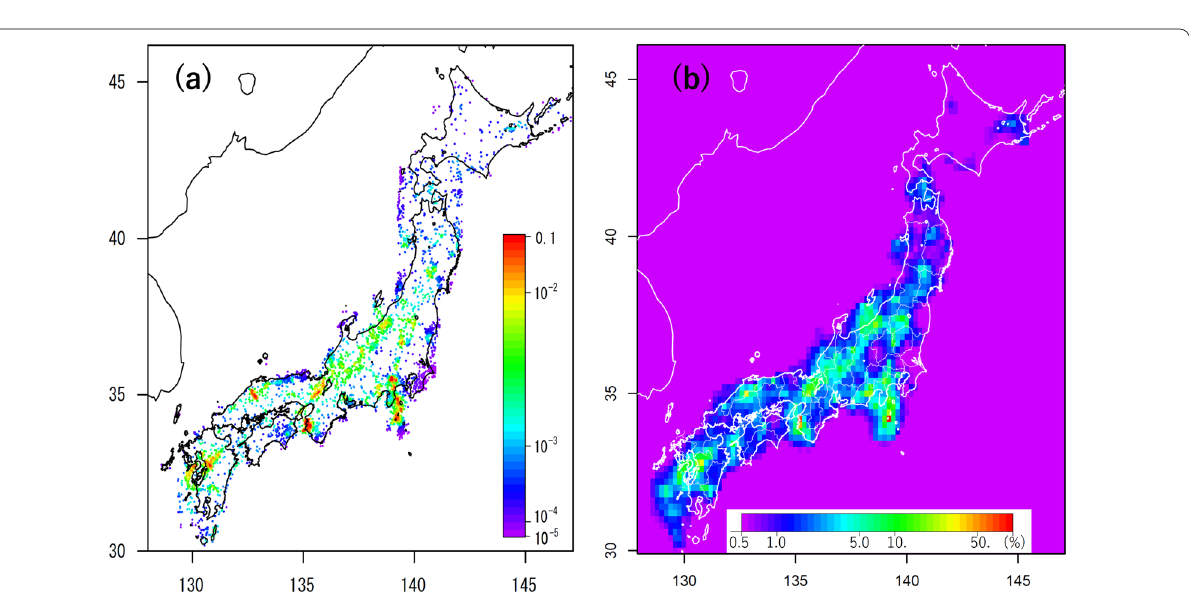
Fig. 5 a Optimal MAP μ ( x , y ) estimate of the HIST–ETAS–5pa model on epicenter locations (colored dots) of earthquakes of M Japan for the target period 1923–2018. The color table refers to the linearized frequency, and the scale represents the probability per day and deg 2 . b Probability of a M 6 shock during the next 30 years in each 0.2° ≥